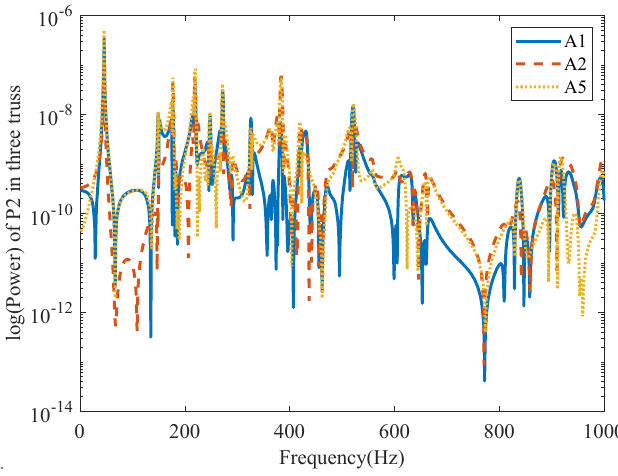
Figure 12. Vibration power flow of P2 in MX direction.